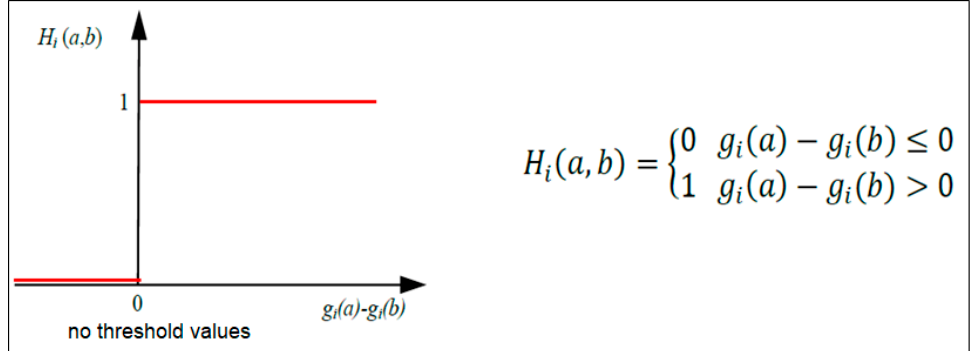
Figure 5. The ordinary preference function—the Promethee method [3,4].